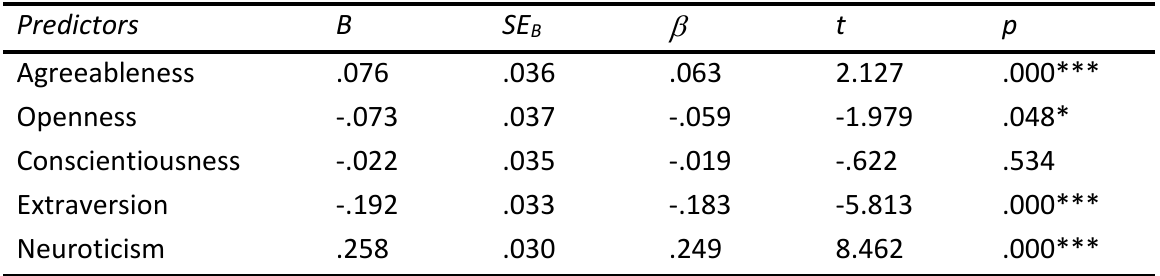
Table 4. Summary of Multiple Linear Regression Analysis with Personality Traits as Predictors of FLSA for ELT students